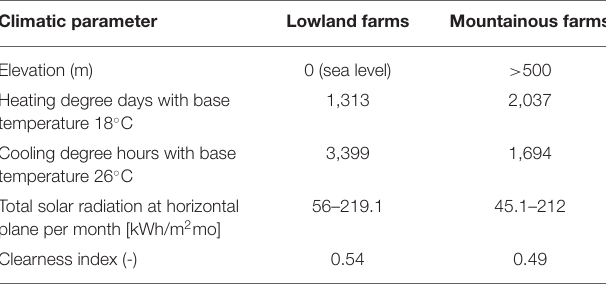
TABLE 2 | Climatic data summary for lowland and mountainous farms. Climatic